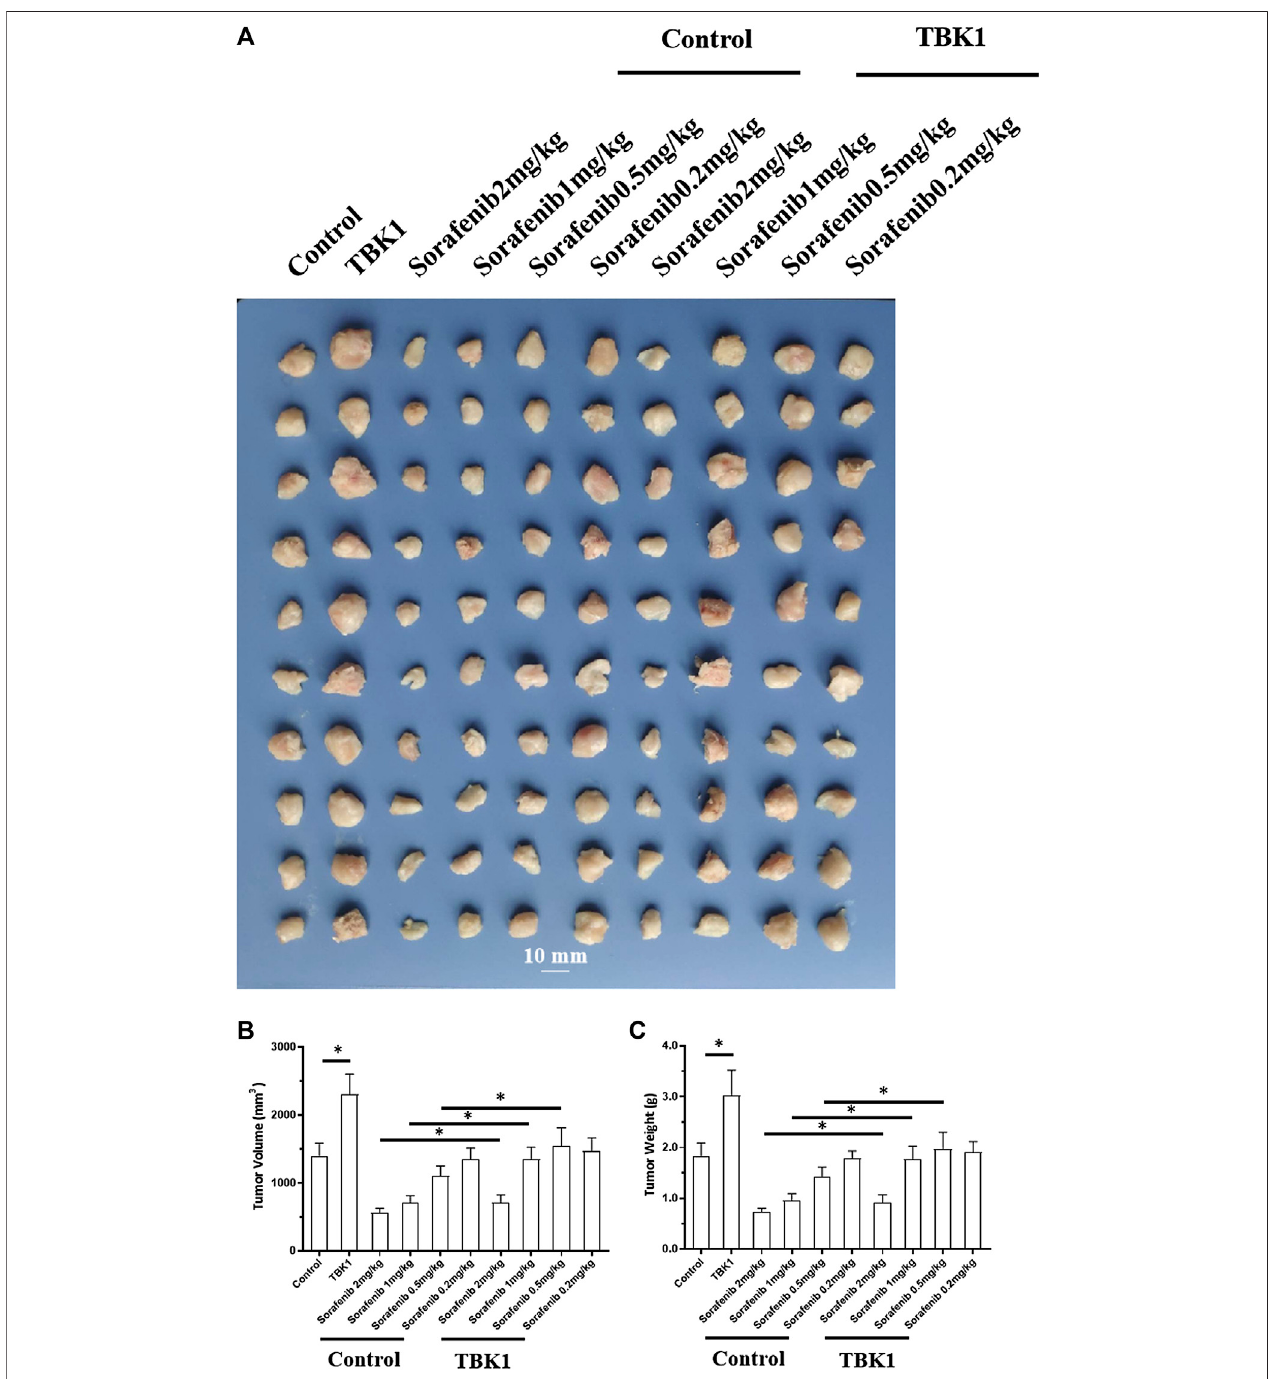
FIGURE5| TBK1 induces resistanceofMHCC97-Lcells tothemolecularly-targeted drug, sorafenib. Aftertransfection of TBK1 inMHCC97-L cells, thecells were inoculatedintonudemice,andthenudemiceweretreatedwithsorafenibbyoralgavage.Afterward,tumor tissues werecollectedtodetermine theirvolumeand weight. Results are displayed as photos of tumor tissue, tumor volume, and tumor weight. * p < 0.05.